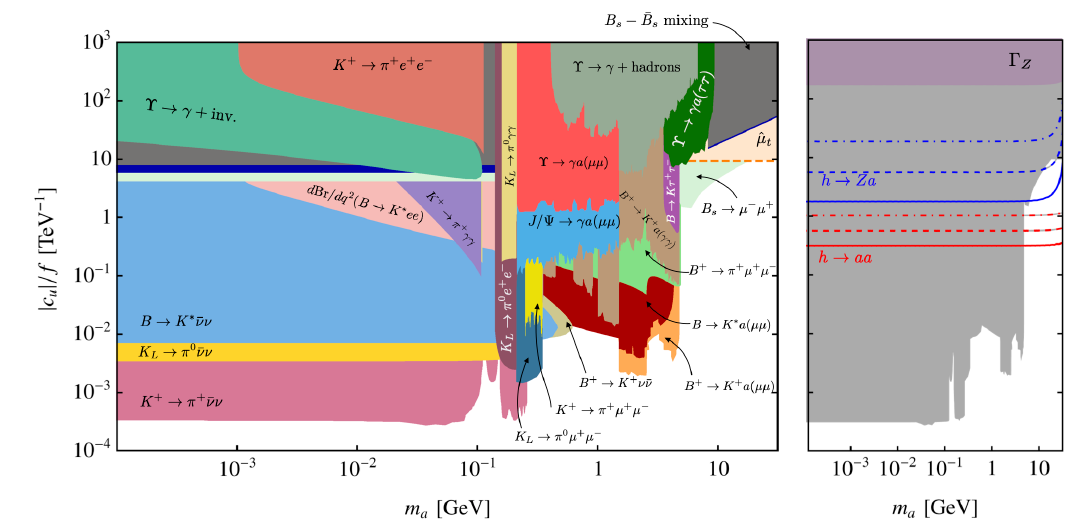
Figure 23 . Left: flavor bounds on universal ALP couplings to right-handed up-type quarks with c u = c u 1 , with all other Wilson coefficients set to zero at Λ = 4 πf and f = 1 TeV. Right: comparison of flavor constraints (light gray) with the constraint on Z → aγ decays from the LEP measurement of the Z boson width, contours of constant Br ( h → aa ) = 10 − 1 , 10 − 2 and 10 − 3 depicted as red dotted, dashed and solid lines and contours of constant Br ( h → Za ) = 10 − 1 , 10 − 2 and 10 − 3 shown as blue dotted, dashed and solid lines,